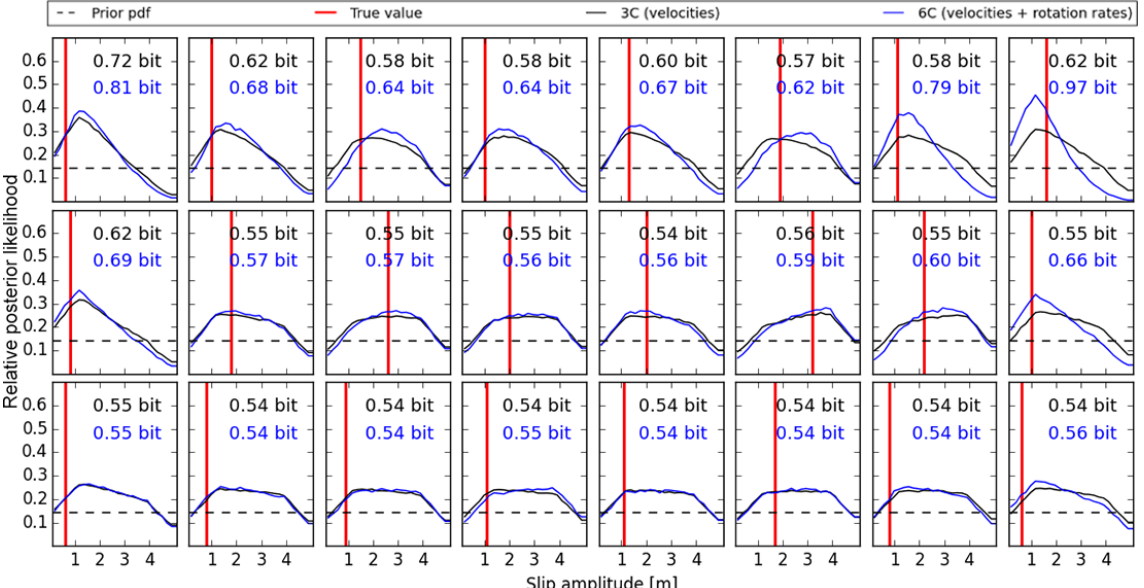
Figure 4. Inversion results for slip amplitudes for a strike-slip fault. Each panel represents a subfault with the same arrangement as in Fig. 2. For each subfault, the homogeneous prior pdf is drawn as a black dashed line, the true value for the slip amplitudes as a red vertical line, and the information gain is noted in the respective color of the inversion (3C in black and 6C in blue). The posterior pdf’s for the 3C and 6C inversions are drawn as black and blue lines, respectively. The quality of the inversion shows a clear decreasing dependency with increasing depth. The bottom layer seems not to be able to be resolved better by the 6C inversion.